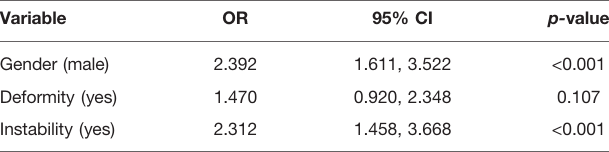
TABLE 7 | Result of logistic